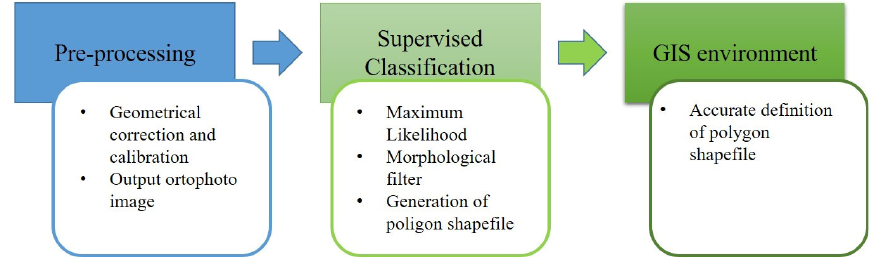
Figure 2. Main processing tasks of semi-automatic extraction UAV polygon data.